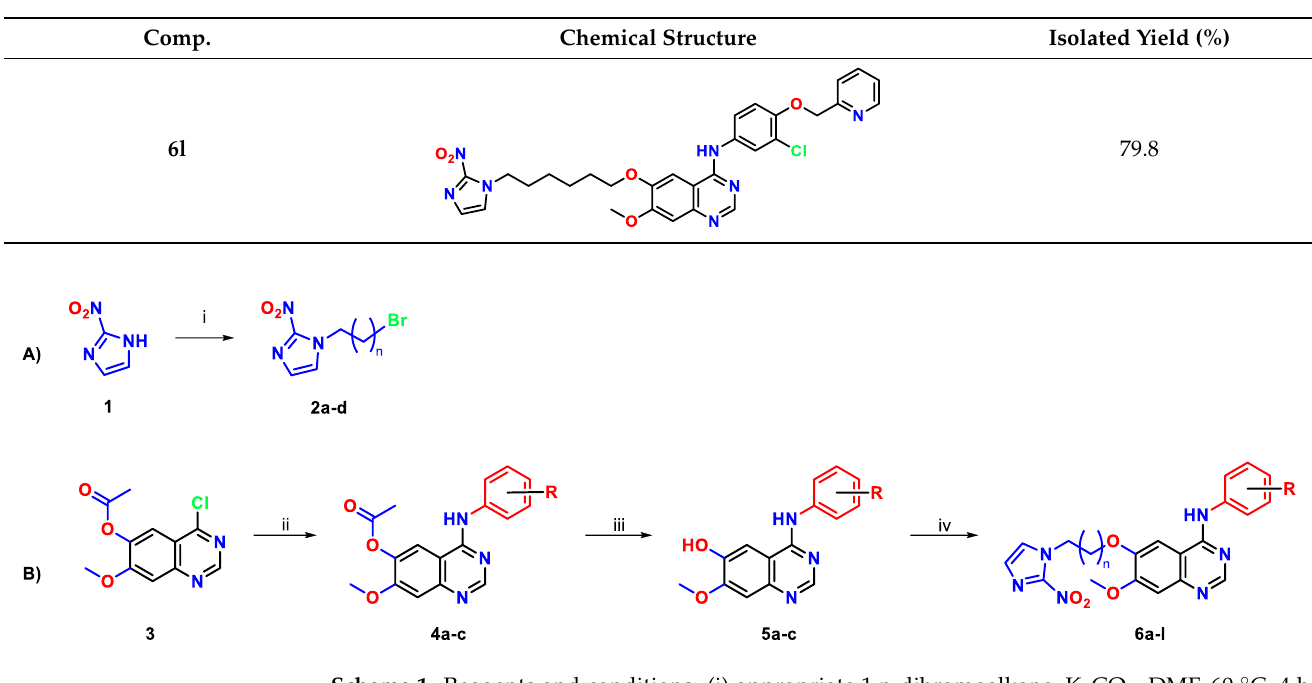
Table 1. Chemical structures and yields of the newly synthesized lapatinib derivatives 6a –